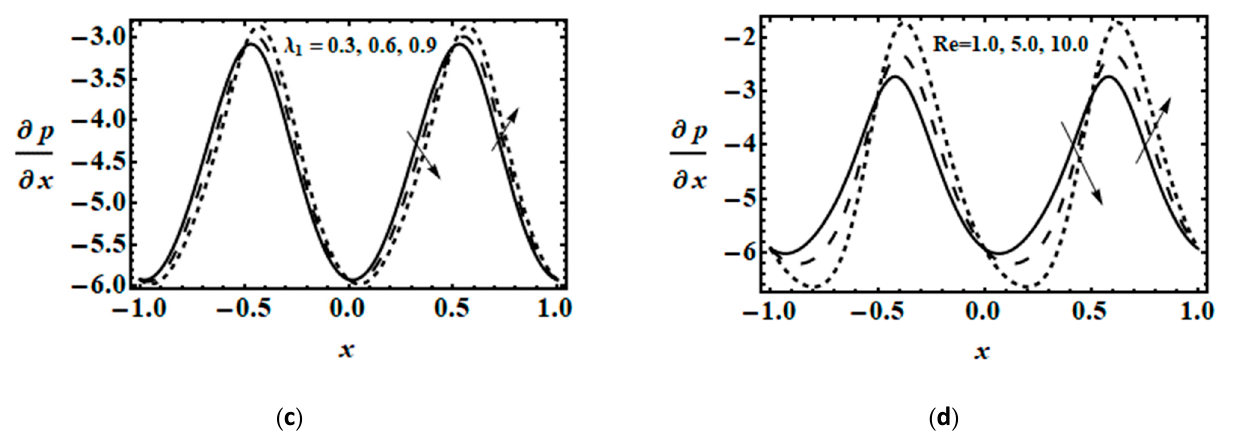
Figure 4. Influence of ( a ) M ( λ 1 = 1, K = 0.1, Re = 0.1), ( b ) K ( λ 1 = 1, M = 1, Re = 0.1), ( c ) λ 1 ( M = 1, K = 0.1, Re = 0.1) and ( d ) 𝑅𝑒 ( λ 1 = 1, M = 1, K = 0.1) on the horizontal pressure gradient for α = 0.4, β = 0.4, ε = 0.1, Q = 1.5.